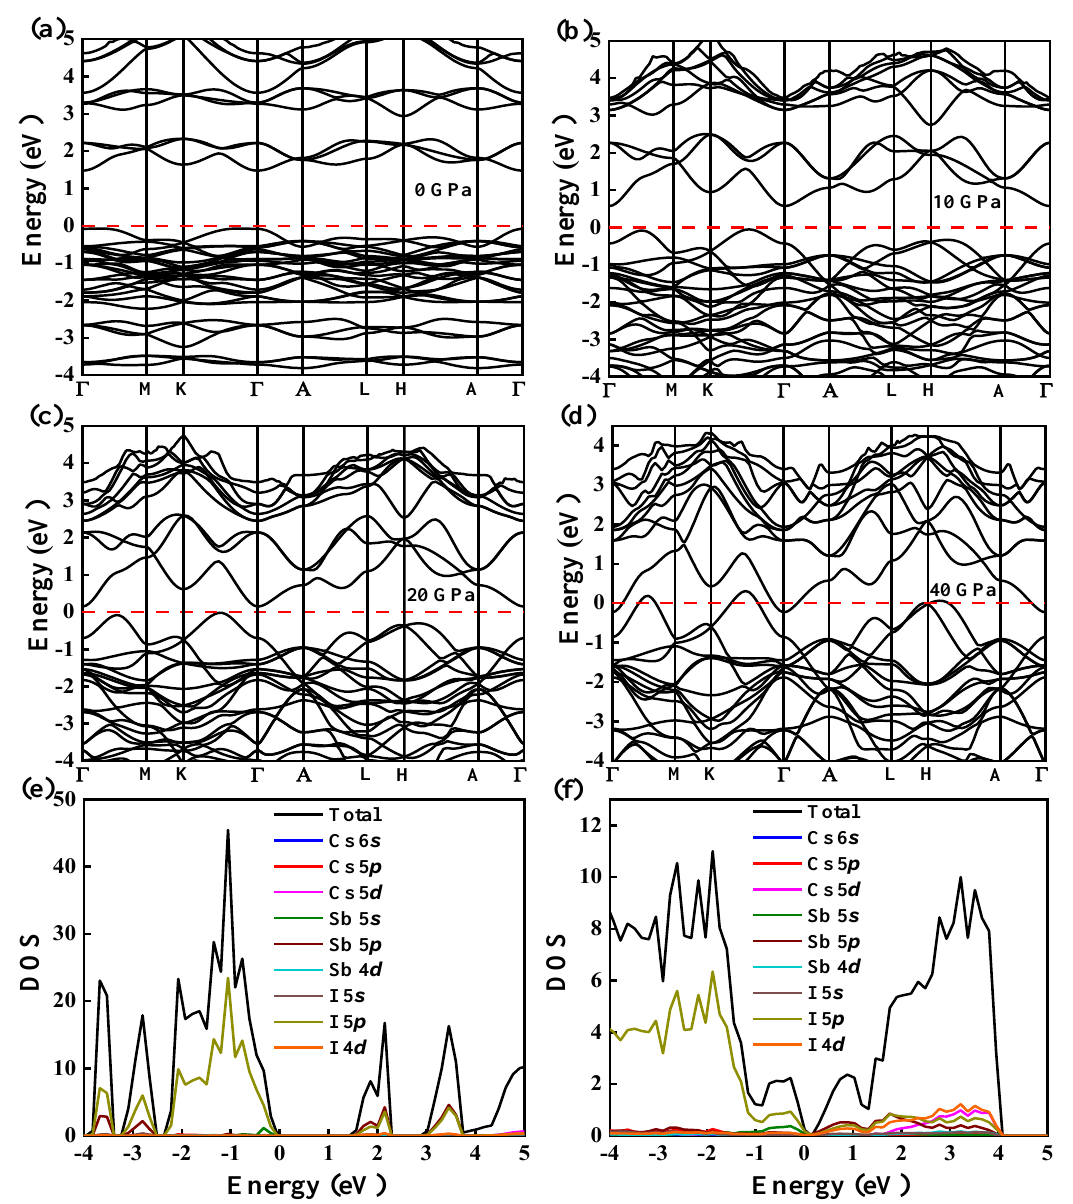
Figure 2. Band structures of Cs 3 Sb 2 I 9 under different pressures of 0 ( a ); 10 ( b ); 20 ( c ); 40 GPa ( d ). The red dashed line is a guide line at 0. Total and partial density of states for Cs 3 Sb 2 I 9 without ( e ) and with ( f ) pressure calculated by PBE functional.